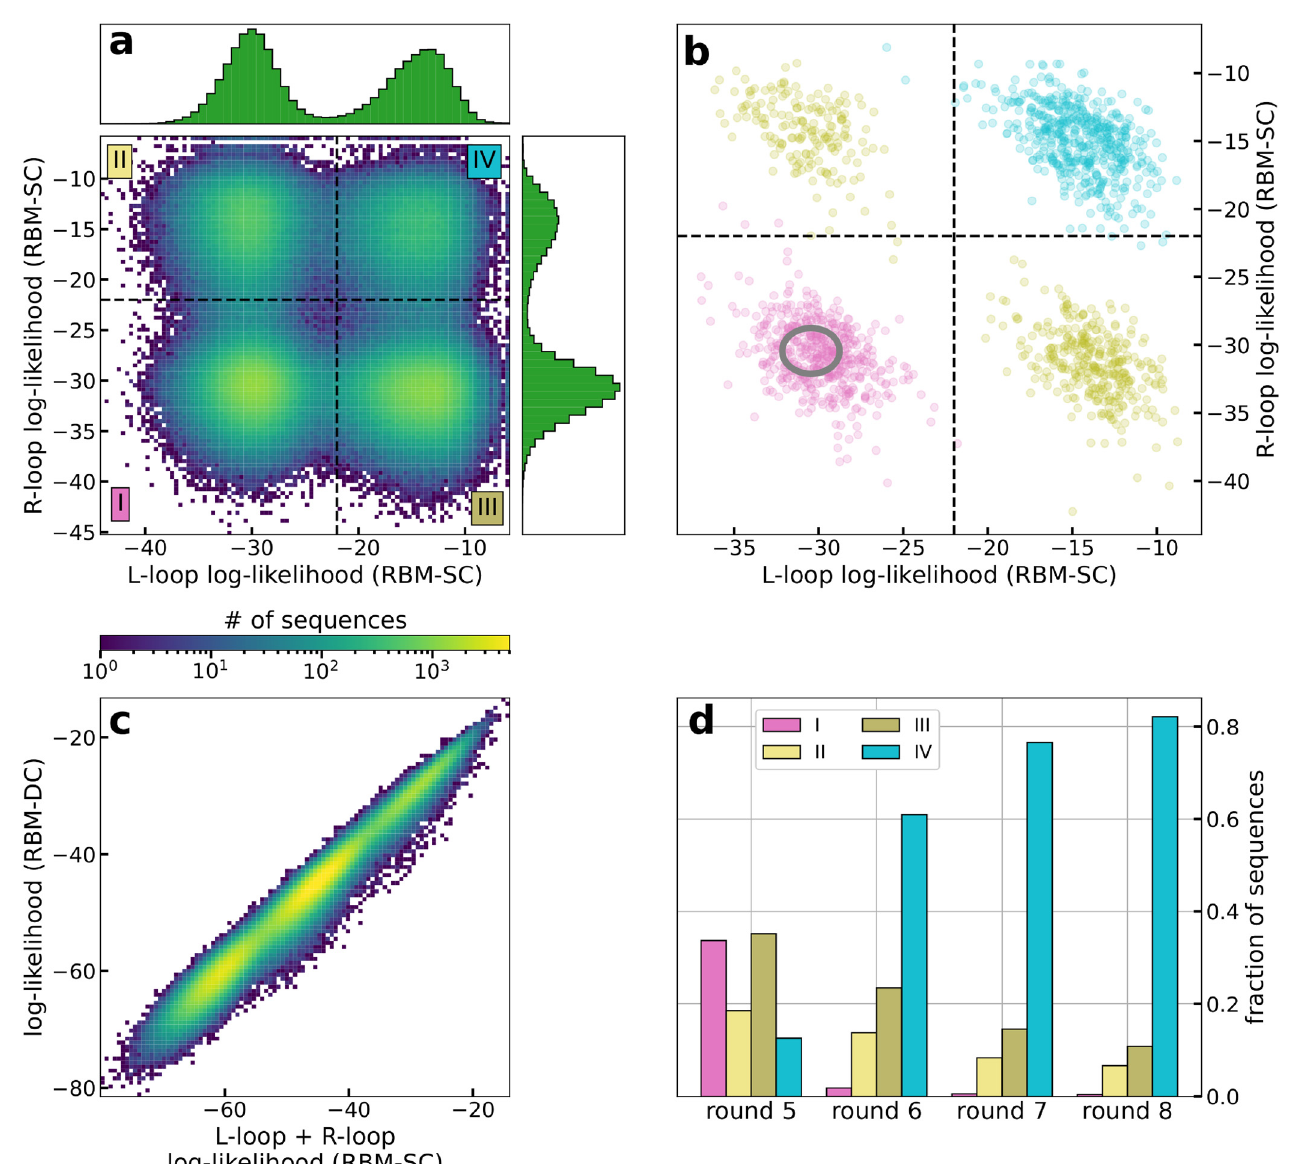
Fig 3. Contribution of left and right loops in the RBM log-likelihood. a : Joint distribution of the log-likelihoods of the L and R loop subsequences at round 5, estimated with RBM-SC trained on subsequences at round 8. The insets show the marginal distributions for both loops. b : Same as panel A for 2000 aptamer sequences attached to each of the three colored peaks in Fig 2A (same color code). The gray ellipse shows the distribution of the log-likelihoods of uniform random sequences (center: mean values, ellipse: 2 standard deviations from the mean). c : Log-likelihoods of the aptamers in round 5 (estimated with RBM-DC see S1 Appendix) vs. sums of the log-likelihoods of their L and R loops (estimated with RBM-SC). d : Fractions of sequences in regions I to IV of panel A at rounds 5, 6, 7 and 8, estimated with the same RBM-SC model as in panel